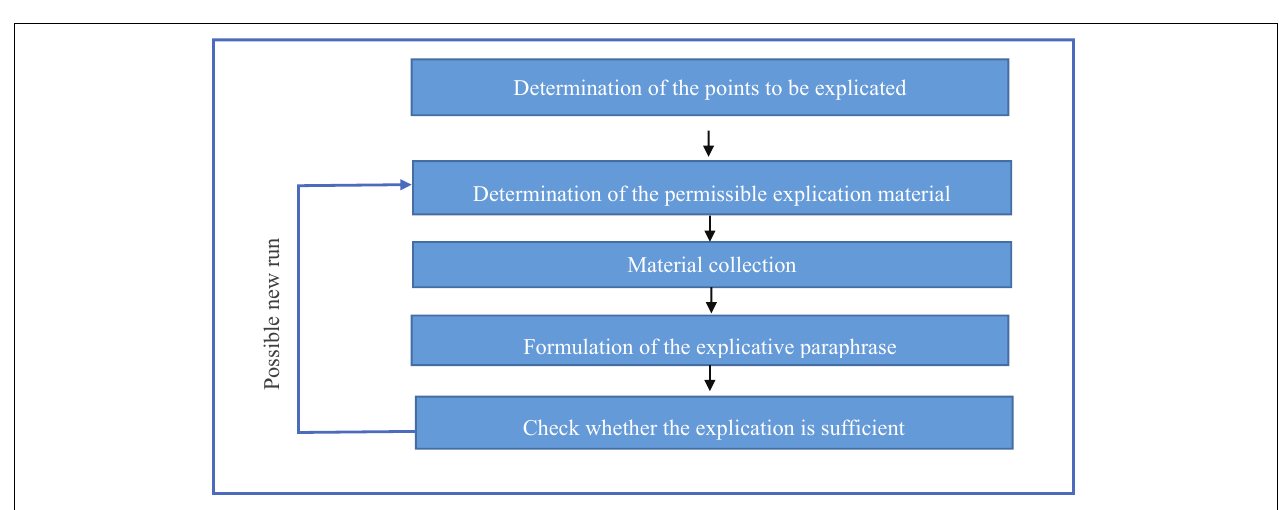
FIGURE 1 | Process model of the summary content analysis (Mayring, 2002).